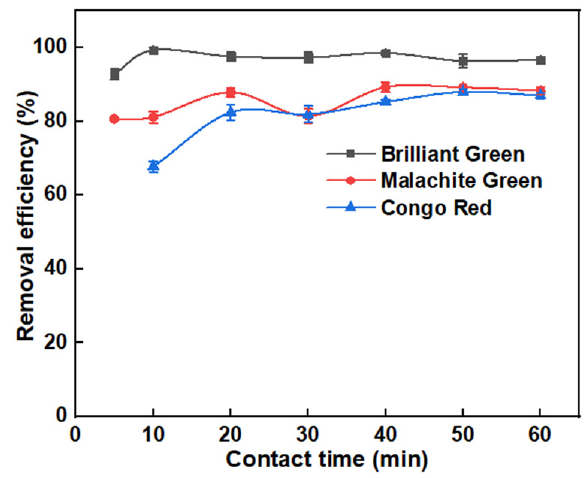
Figure 4. Effect of contact time on BG, MG and CR removal efficiency of OPL 1000 CNSs.